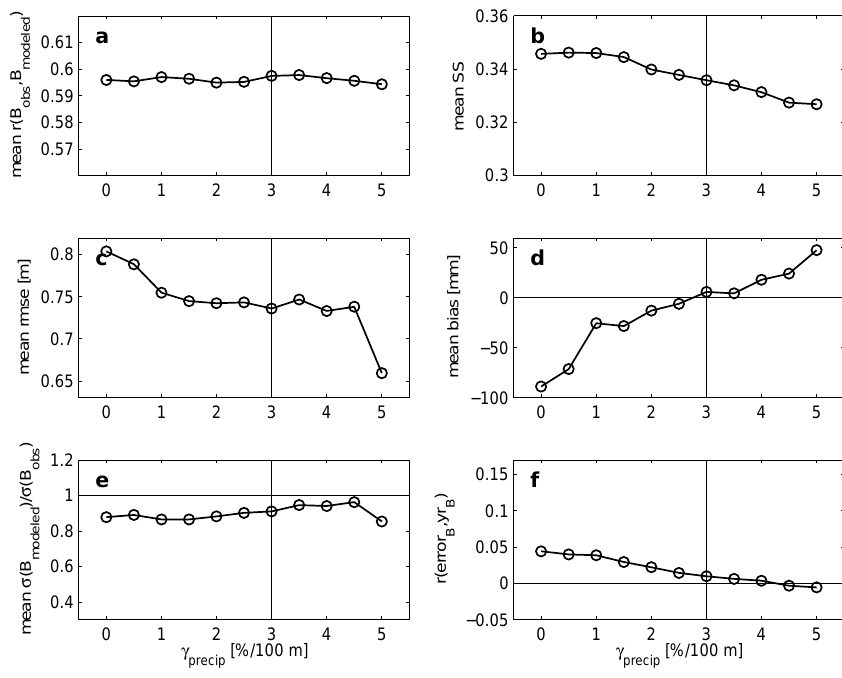
Fig. 5. As Fig. 4, but for the precipitation lapse rate γ precip .